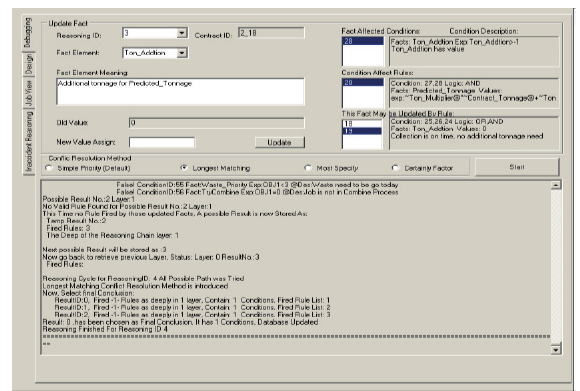
Fig. 10. Example of Reasoning Procedure Screen